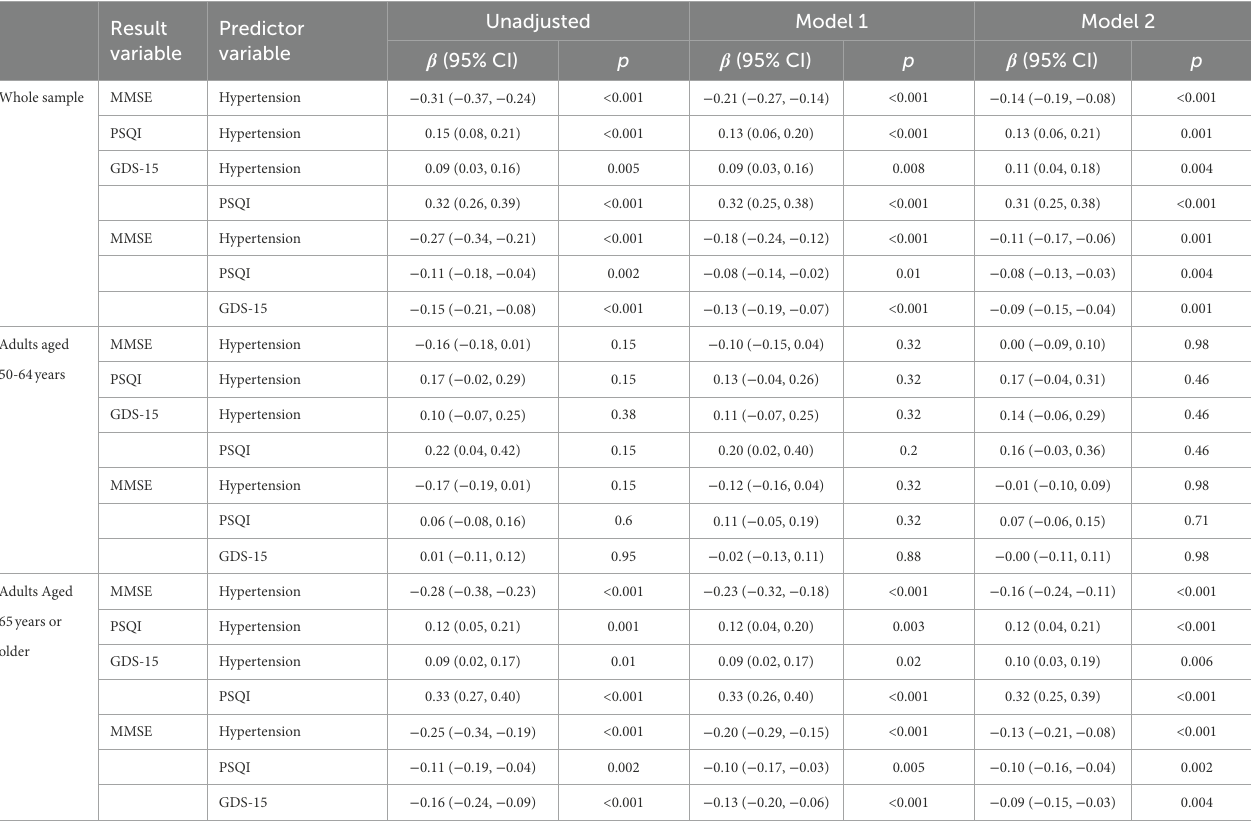
TABLE 3 Associations from multiple linear regression models of hypertension with sleep quality, depression and cognitive